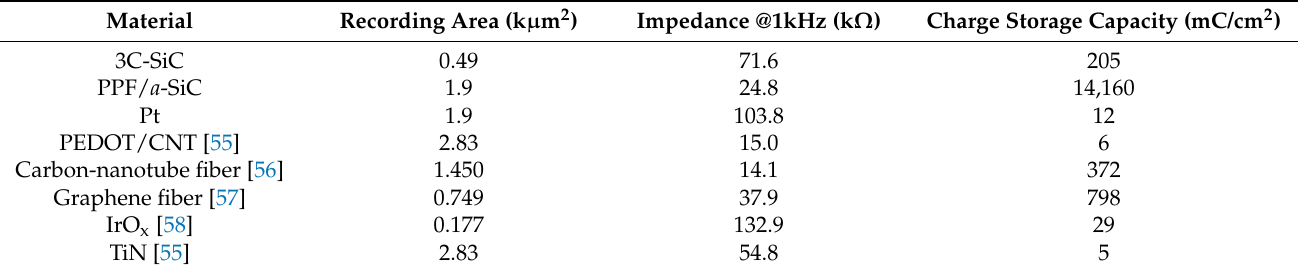
Table 1. Electrochemical properties of SiC and common mINP electrode